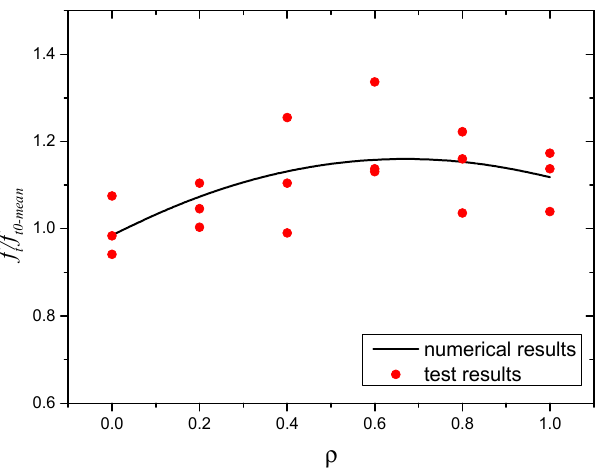
Figure 17. f t of SWSSC specimens with different ρ .